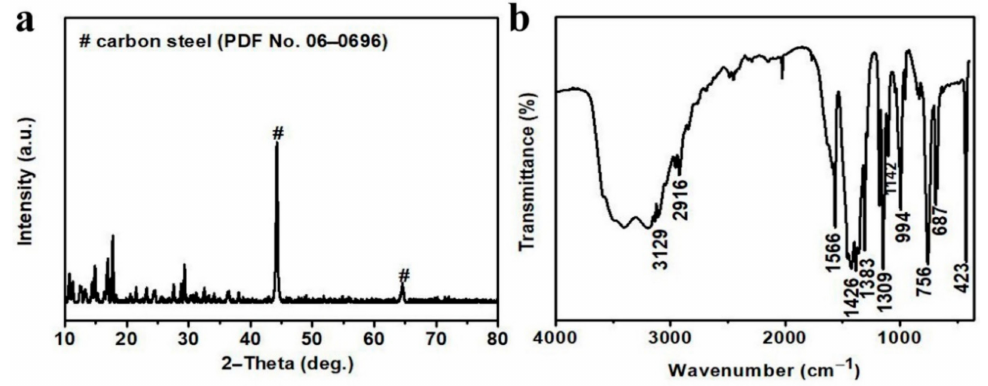
Figure 2. ( a ) XRD pattern and ( b ) FT-IR spectrum of the Zif-8 coating